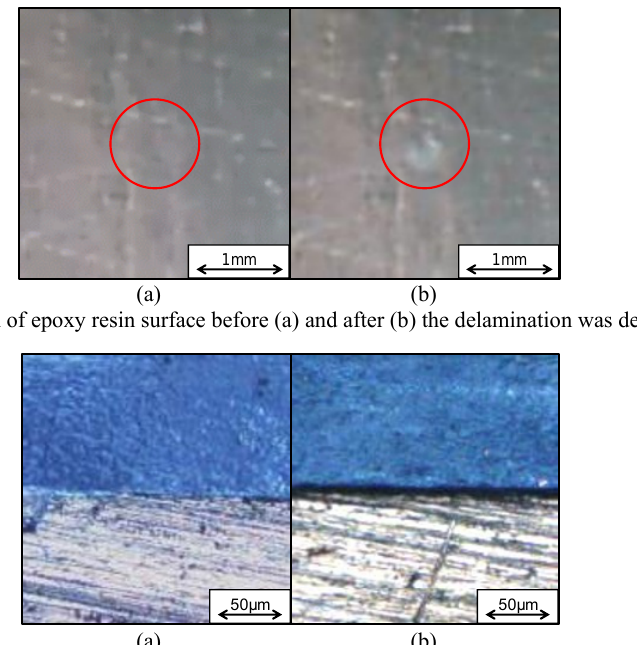
Fig. 5. Optical micrograph of cross section of room temperature cured specimen before (a) and after (b) the